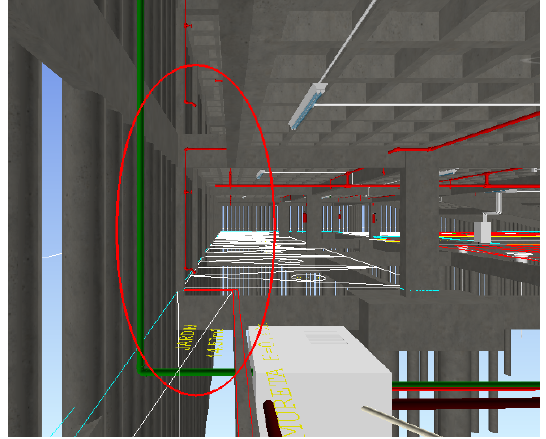
Figure 6: Needed validation for path of discharge pipes.